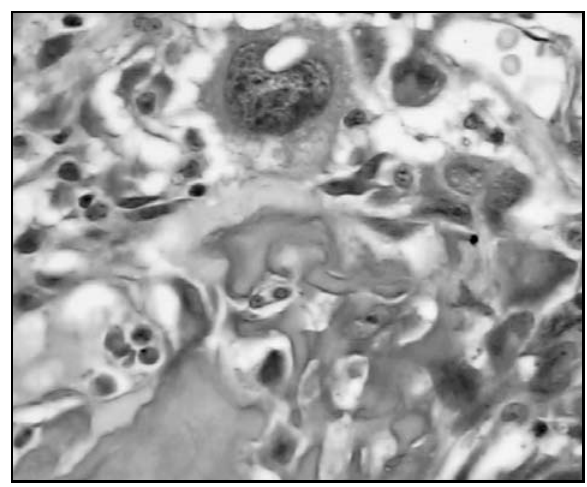
Figura 2 – Cariomegalia acentuada: achado anaplásico (HE 400x)